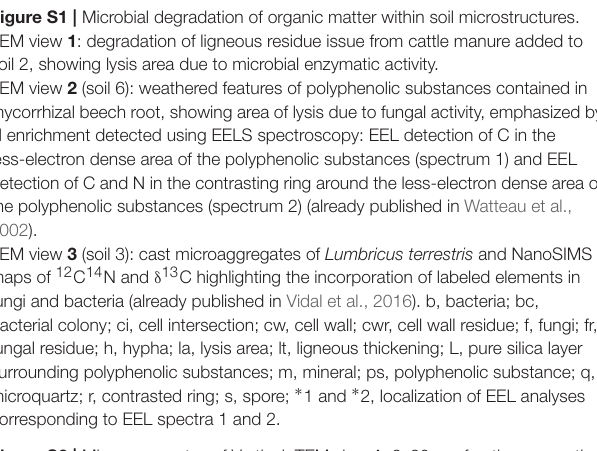
Figure S2 | Microaggregates of Vertisol. TEM view 1 : 2–20 µ m fraction presenting the 3 types of microaggregates; TEM view 2 : “organo-mineral” aggregate; TEM view 3 : bacterial aggregate; TEM view 4 : “mineral” aggregate and corresponding EDX spectrum 1 and 2 for respectively fine organic matter (presence of C and Os) and clay. b, bacteria; ba, bacterial aggregate; cw, plant cell wall; ex, exopolymer; ma, mineral aggregate; m, mineral; om, organic matter; oma, organo-mineral aggregate; pr, plant residue; ∗ 1 and ∗ 2, localization of EDX analysis 1 and